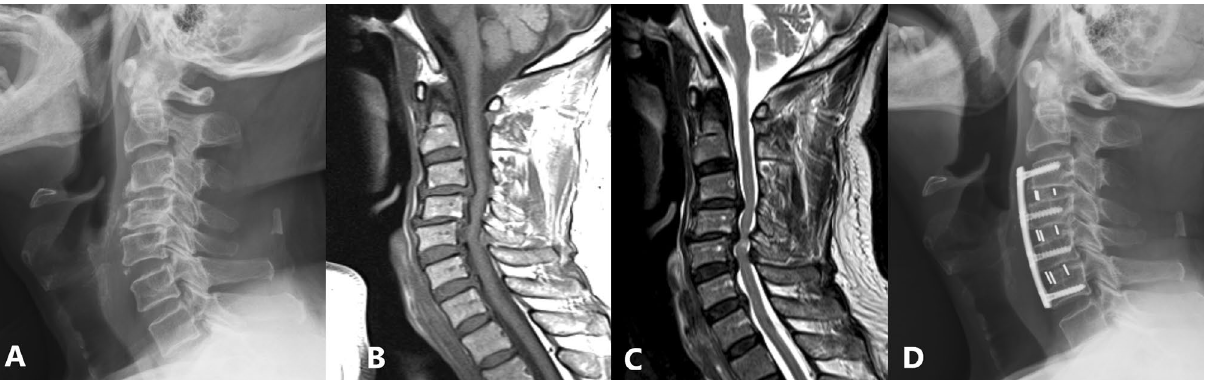
Figure 3. An 80-year-old male had degenerative cervical myelopathy from C3 to C6. Preoperative MRI T1W and T2W images shows spinal cord compression from C3 to C6 and cord edema at C4–C5. ( a – c ) He underwent three-level ACDF from C3 to C6 using four PEEK cages and one long anterior plate. Postoperative lateral cervical spine radiography at 1 year showed successful fusion from C3 to C6, maintenance of intervertebral heights, stable C2–C7 Cobb angle and improved C2–C7 SVA. ( d ) He had clinical improvement and smooth postoperative follow-up until 4 years later, having right middle cerebral artery territory infarction with left